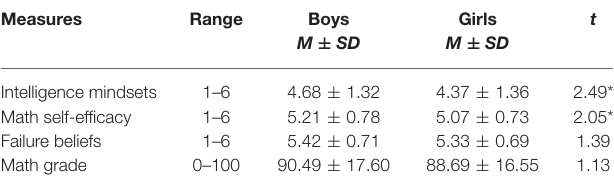
TABLE 2 | Mean differences by gender and t -test